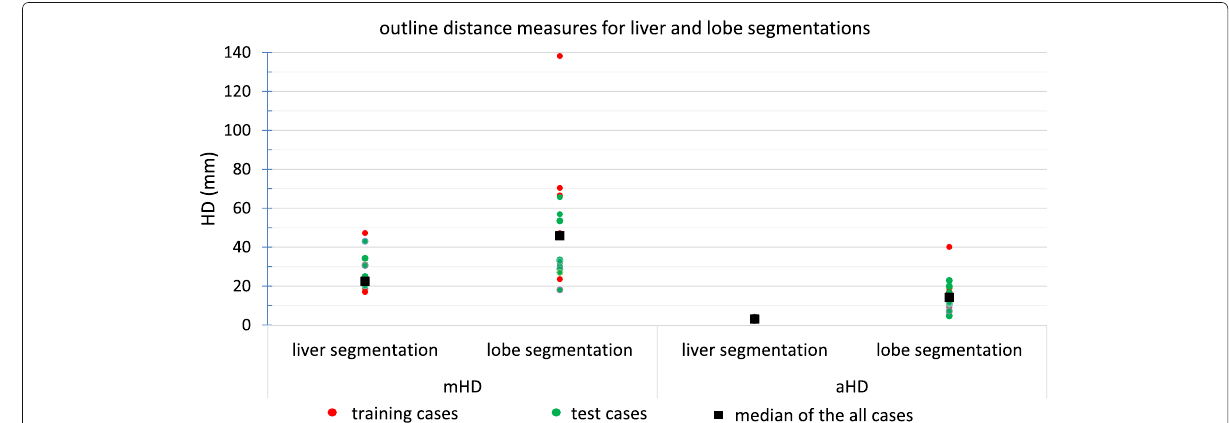
Fig. 11 Outline maximum and average Hausdorff distance measures (mHD and aHD) between manual and automatic liver segmentation and two different lobe separation planes (on CT and on CBCT) for training and test